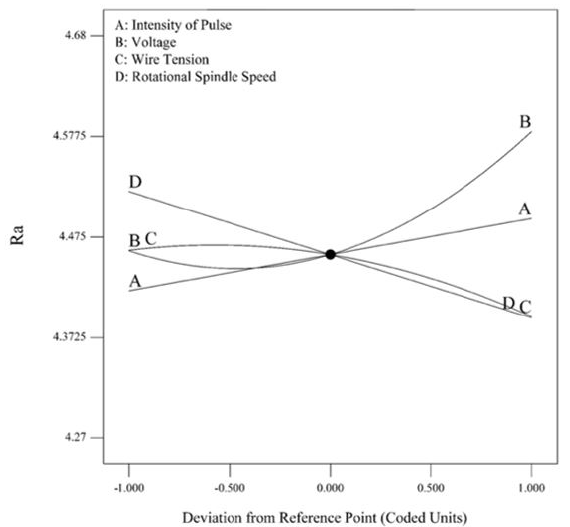
Fig. 4. Perturbation plot for surface roughness performance ( p < 0.05) decrease with the decrease of A and B from 2.8 to 2.4 A, 30 to 26 V, and a significant ( p < 0.05) increase in the rotational spindle speed from 400 to 2400 rev/min and wire tension from 12.2 to 14.8